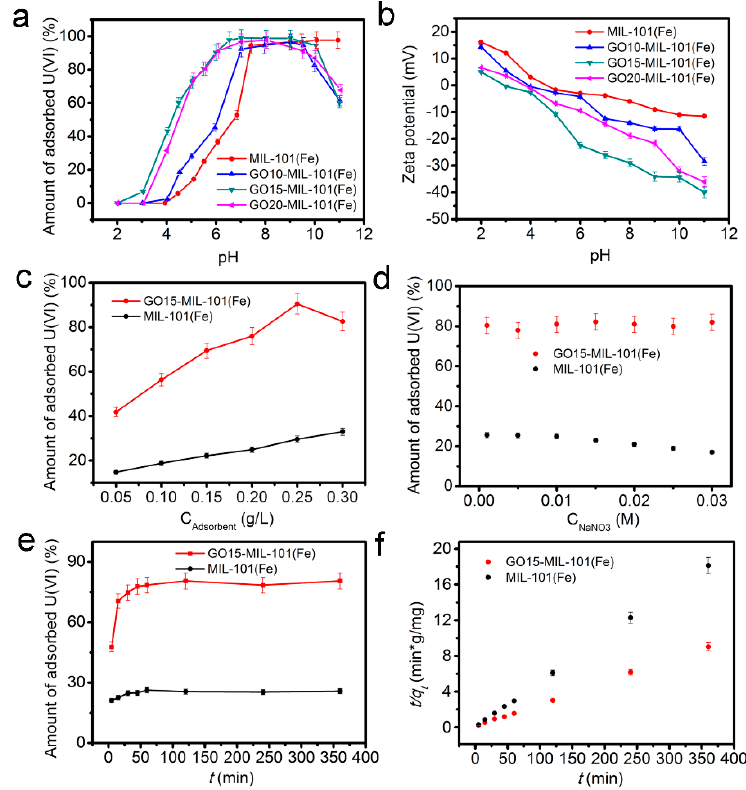
Figure 4. ( a ) The adsorption efficiency of the MIL-101(Fe) and GO-MIL-101(Fe) composite towards U(VI) as a function of pH ( C 0 = 10 mg L − 1 , T=298 K, m / V = 0.2 g L − 1 , and I NaNO = 0.01 M), ( b ) the effect of pH on the zeta potential of the GO10 (15, 20)-MIL-101(Fe) composite and MIL-101(Fe), the effect of ( c ) adsorbent dose and ( d ) ionic strength on the adsorption efficiency of MIL-101(Fe) and GO15-MIL-101(Fe) composites. ( e ) The amount of uranyl ions adsorbed on MIL-101(Fe) and GO15-MIL-101(Fe) composites under different contact times. The experimental condition is C 0 = 10 mg L − 1 , pH = 5.5, T = 298 K, m / V = 0.2 g L − 1 , and I NaNO = 0.01 M for ( b – e ). ( f ) pseudo-second-order simulation result for the adsorption of the U(VI) on MIL-101(Fe) and GO15-MIL-101(Fe) composites. Table 1. The kinetic parameters for U(VI) adsorption on MIL-101(Fe) and GO15-MIL-101(Fe). Pseudo-First-Order C 0 (mg L − 1 )